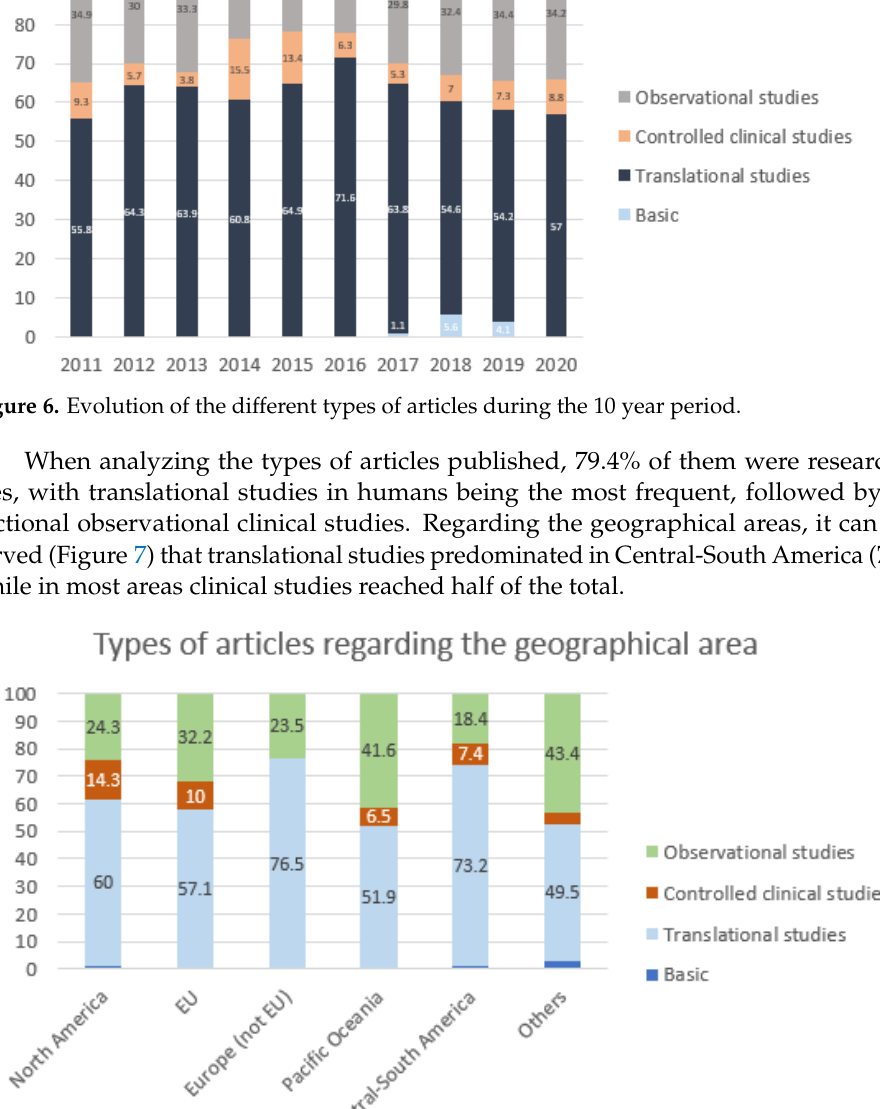
Figure 5. Distribution of article types.